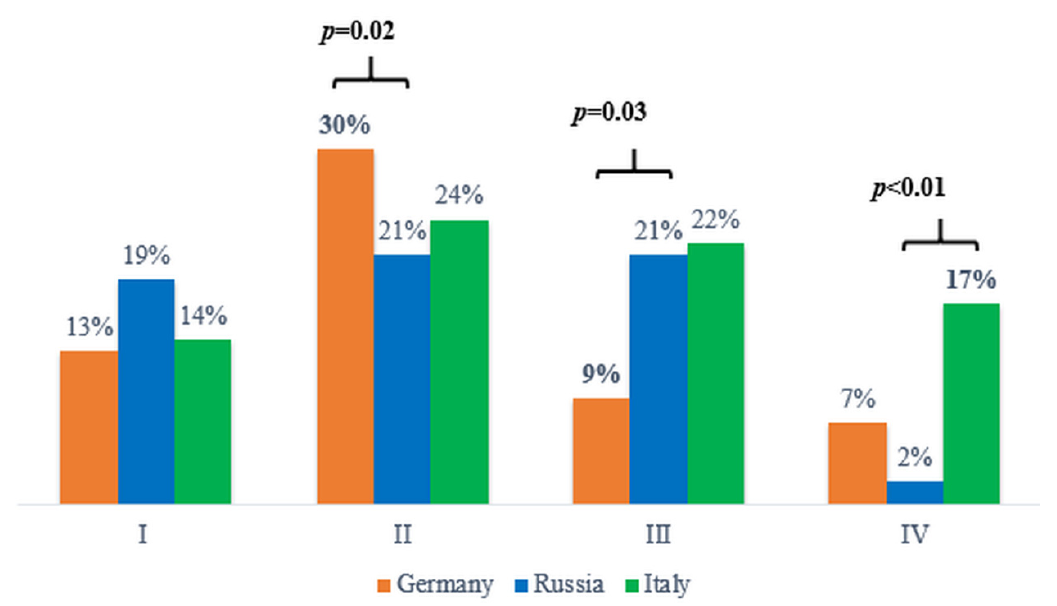
Figure 4. MSI frequencies at stages I-IV CRC.